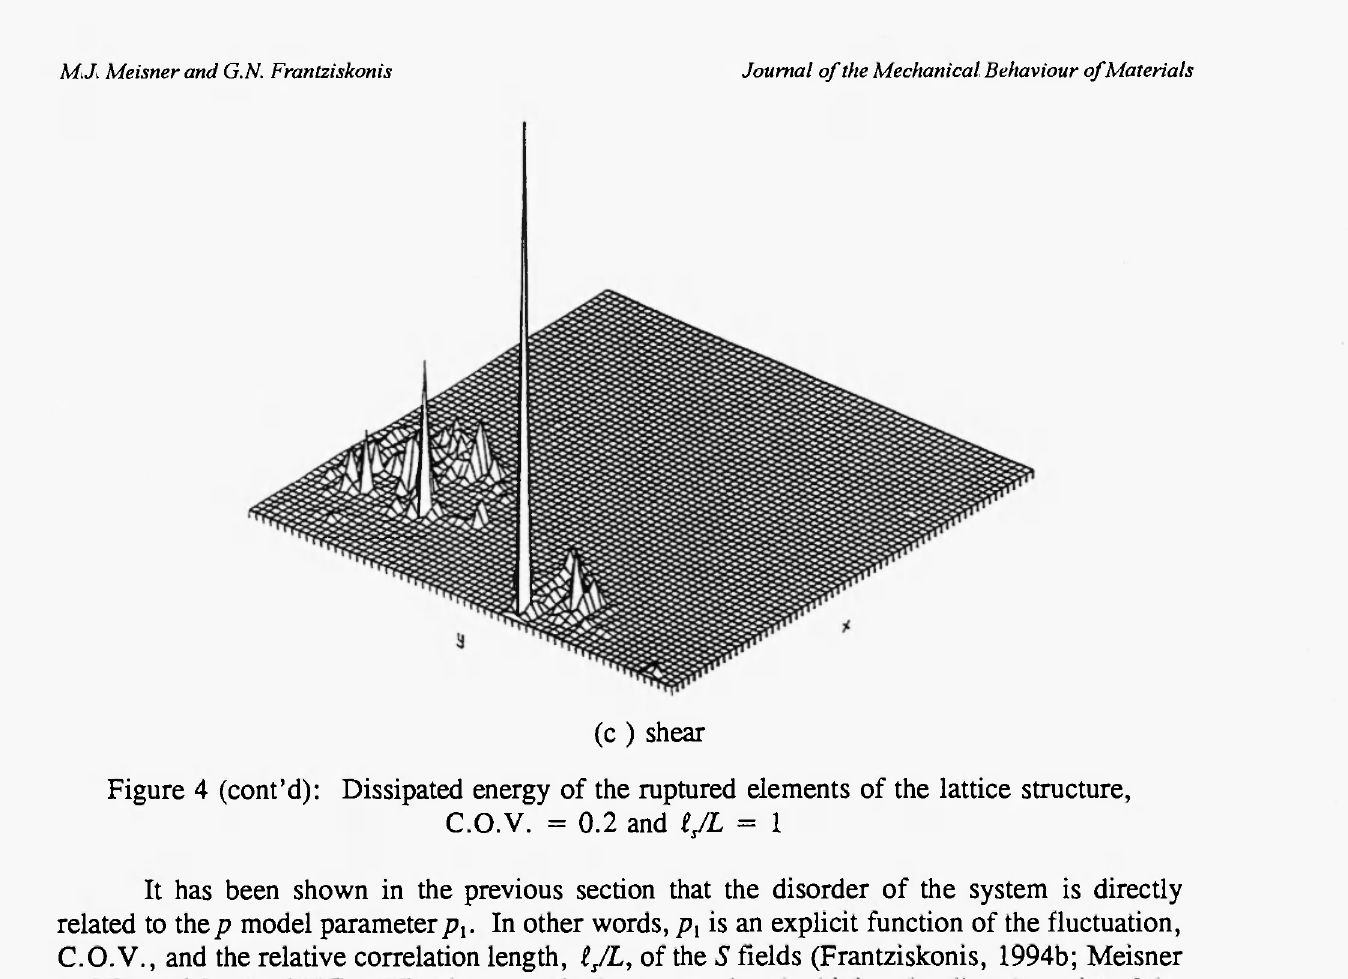
Figure 4 (cont'd): Dissipated energy of the ruptured elements of the lattice